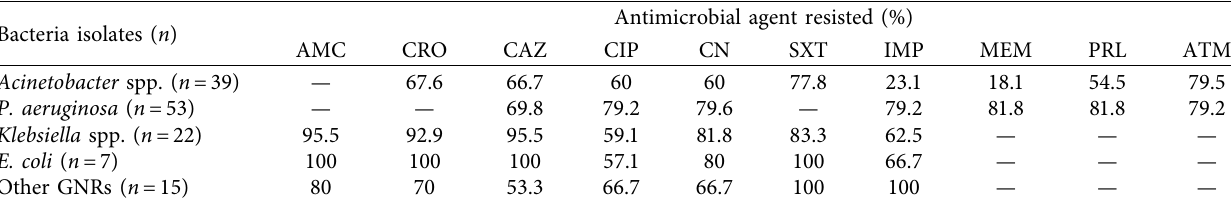
Figure 1: Distribution of aerobic Gram-negative pathogenic bacterial isolates from children with burn wound infections. GNR, Gram- negative rod. Other GNRs are Enterobacter spp., Proteus spp., Rahnella aquatilis , Raoultella spp., and Stenotrophomonas spp. Table 2: Antimicrobial resistance pattern of Gram-negative bacteria isolated from children with BWI.